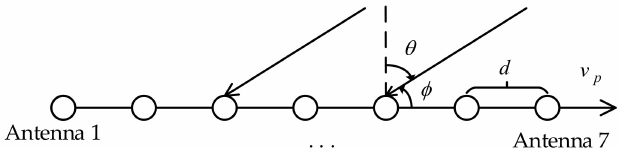
Figure 2. The geometry of the receiving array